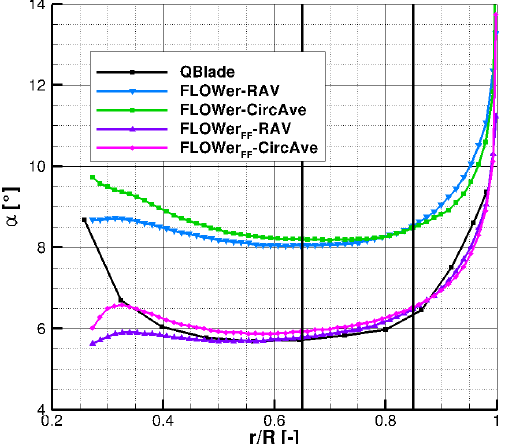
Figure 16. AoA distribution over the normalized blade radius at an azimuth = 0 ◦ for QBlade and FLOWer (RAV and CircAve for wind tunnel and far field each). Black lines indicate the evaluation positions of Figs. 15, 17 and